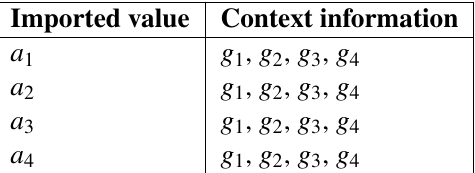
Table 1 Context of import